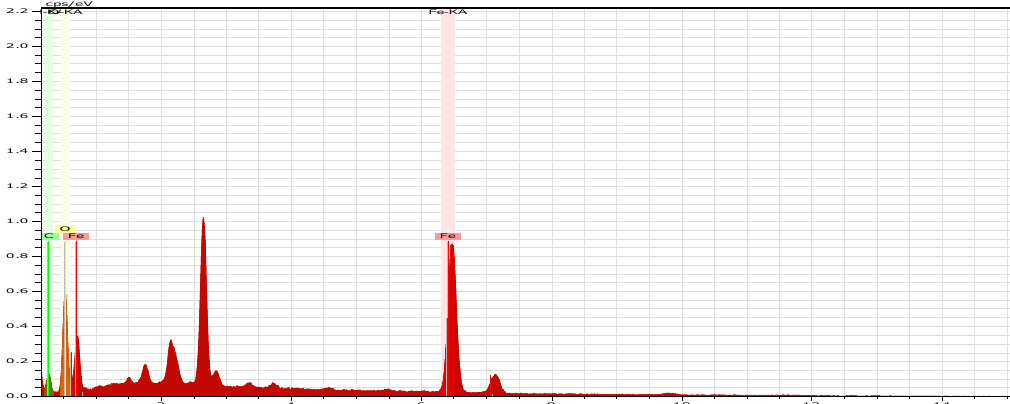
Fig. 5. EDS Chart of Fe-NPs.